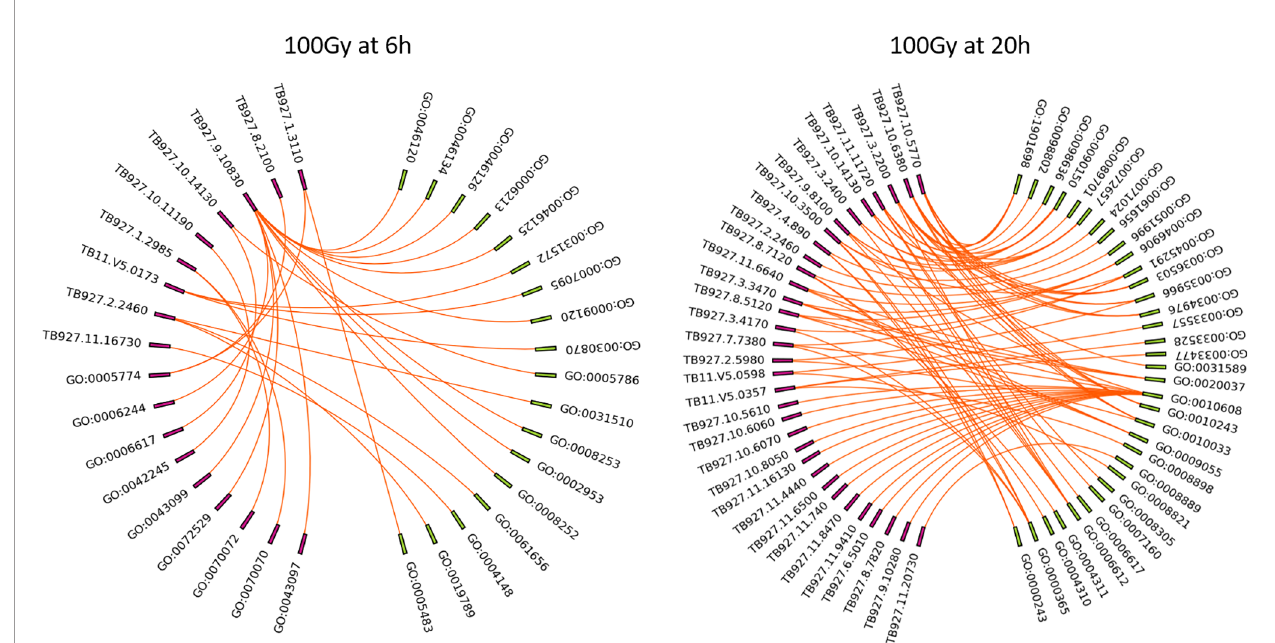
FIGURE 9 | Chord plots for the positive Z score GO enrichment terms and associated genes at 6h and 20h post 100Gy irradiation. All the processes at 6h and 20h post-irradiation were plotted with corresponding genes to identify individual genes involved in multiple processes and given a chord plot count i.e., the higher the count a gene has, the more processes it will be involved